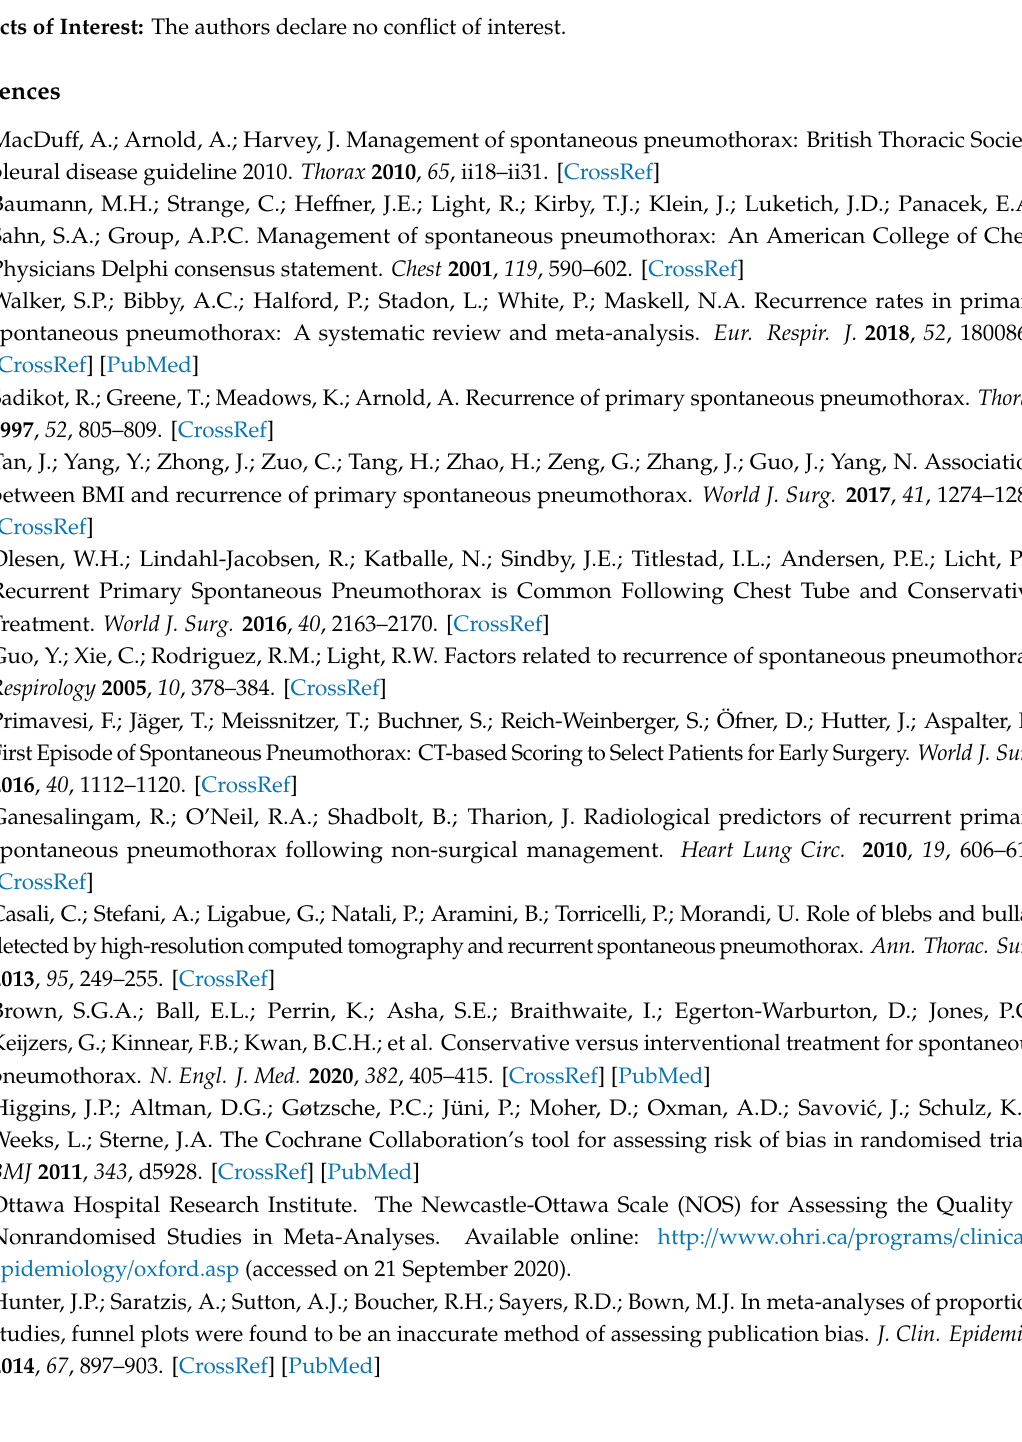
Figure S4: Subgroup analysis comparing conservative management and chest tube drainage in terms of adverse events during treatment. (A) Study design, (B) allocation of the primary spontaneous pneumothorax